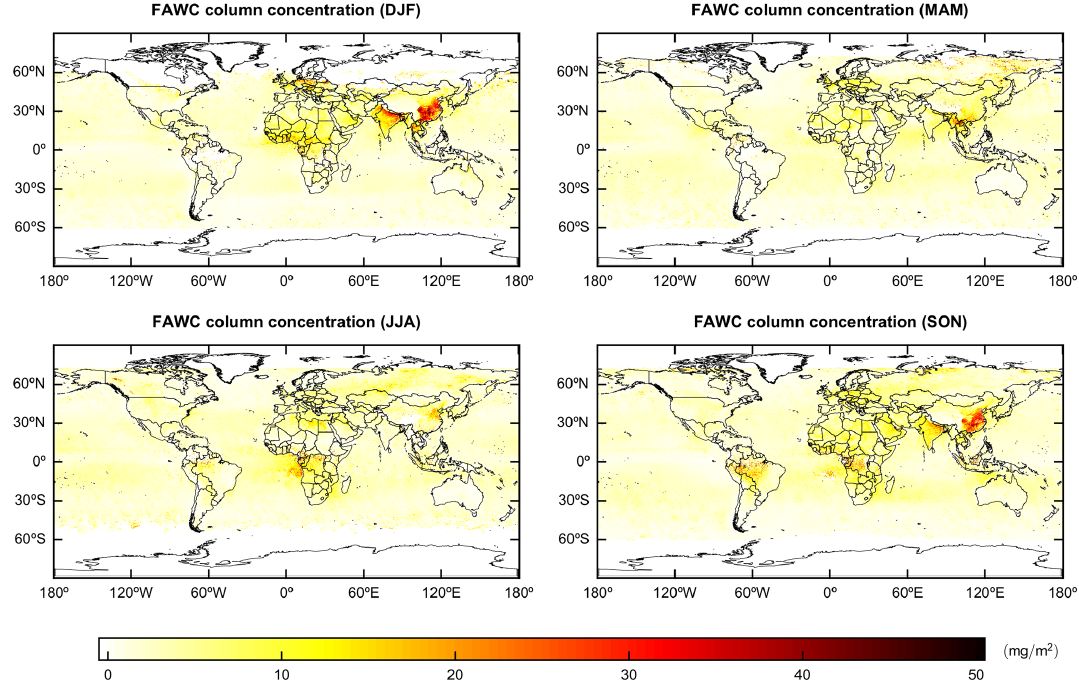
Figure 18. Spatial distribution of seasonal fine-mode aerosol water content (FAWC) column mass concentration (mgm − 2 ) derived from POLDER-3 observations using the GRASP/Component approach. December–January–February (DJF); March–April–May (MAM); June– July–August (JJA); September–October–November (SON).